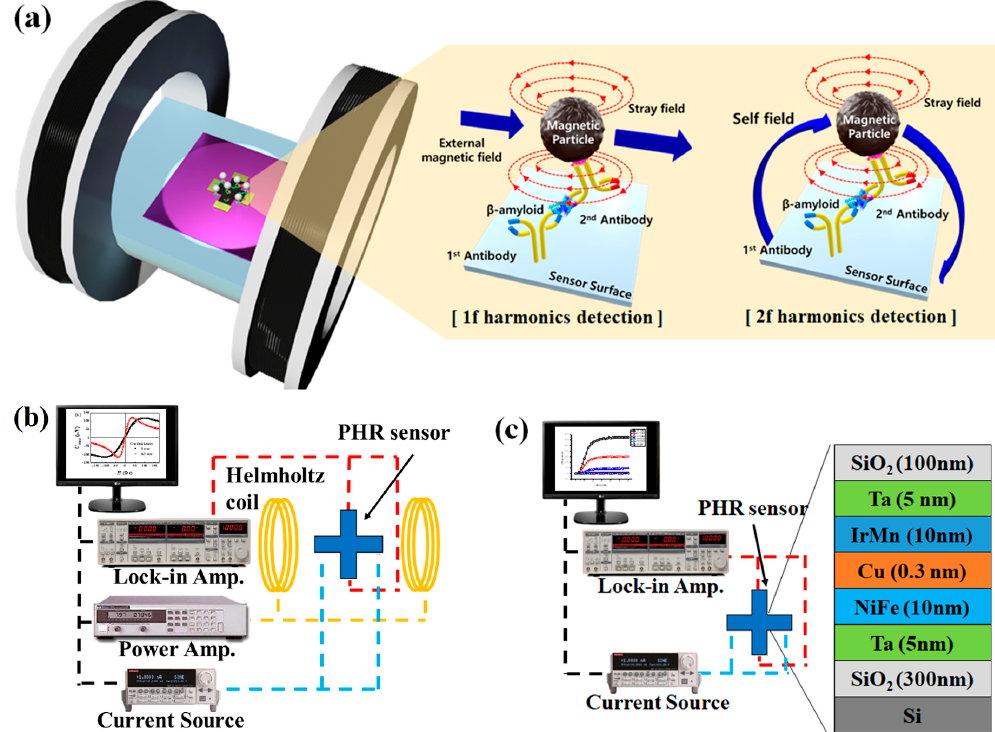
Figure 1. ( a ) Schematics of the planar Hall resistance (PHR) biosensor working principle in 1f and 2f detection mode. ( b ) Block diagram of the experimental setup for the 1f detection mode. ( c ) Block